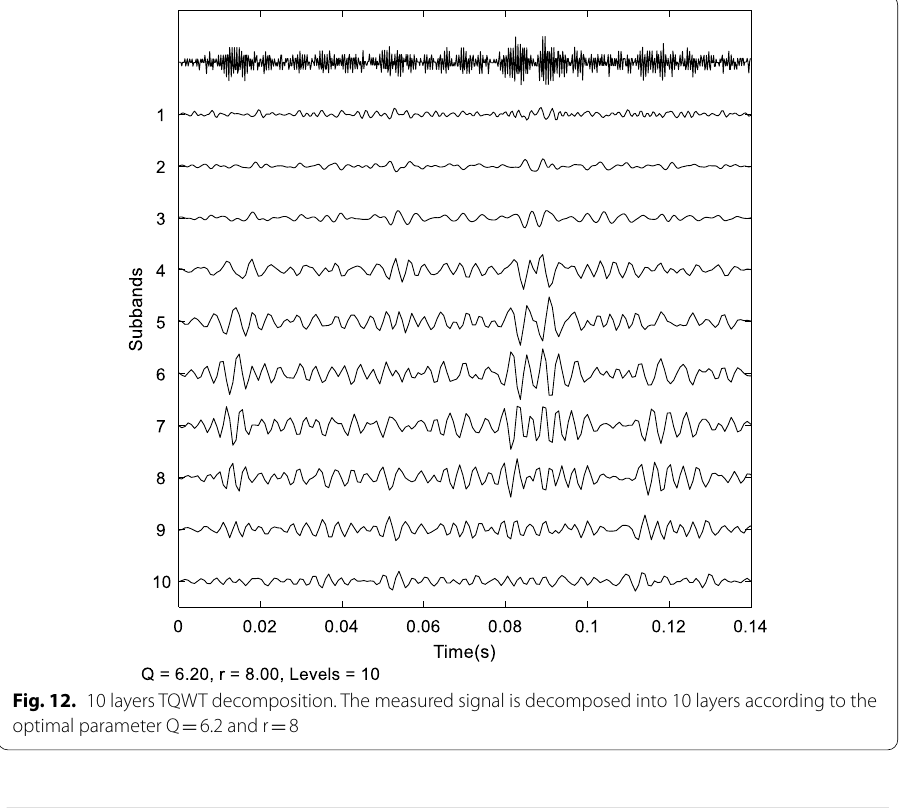
Fig. 12. 10 layers TQWT decomposition. The measured signal is decomposed into 10 layers according to the optimal parameter Q 6.2 and r 8 = =